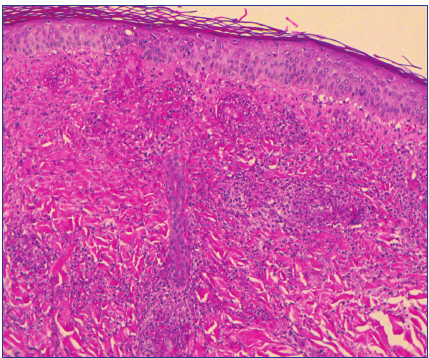
Figure 1: Skin biopsy showing classic features of small vessel vasculitis with neutrophilic infiltration of the vessel walls, karyor- rhexis, and fibrinoid necrosis of vessel walls as well as extensive extravasation of red blood